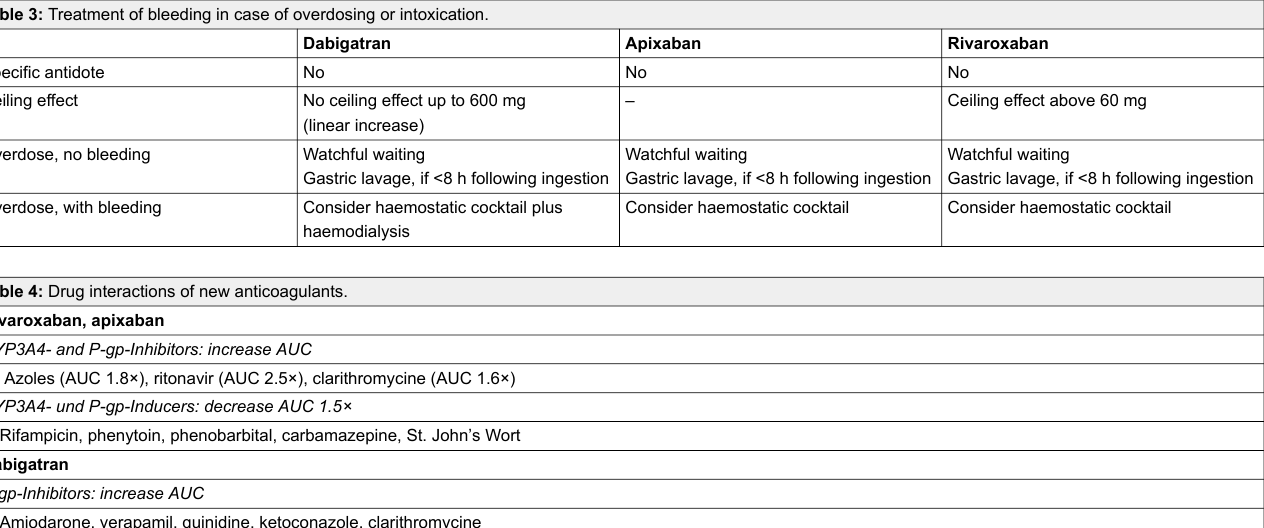
Table 4: Drug interactions of new anticoagulants. Rivaroxaban, apixaban CYP3A4- and P-gp-Inhibitors: increase